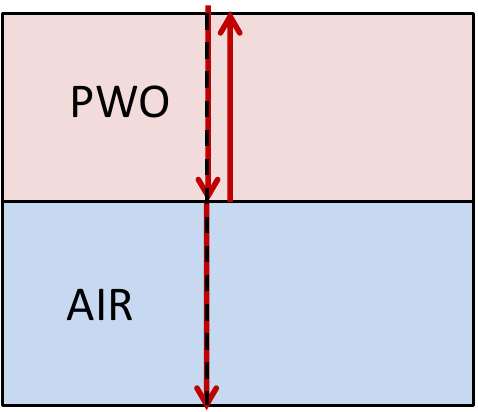
Figure 5. The wave path inside and outside (air) the sample. The wave, indicated by the red arrow, travels normally to the interfaces.